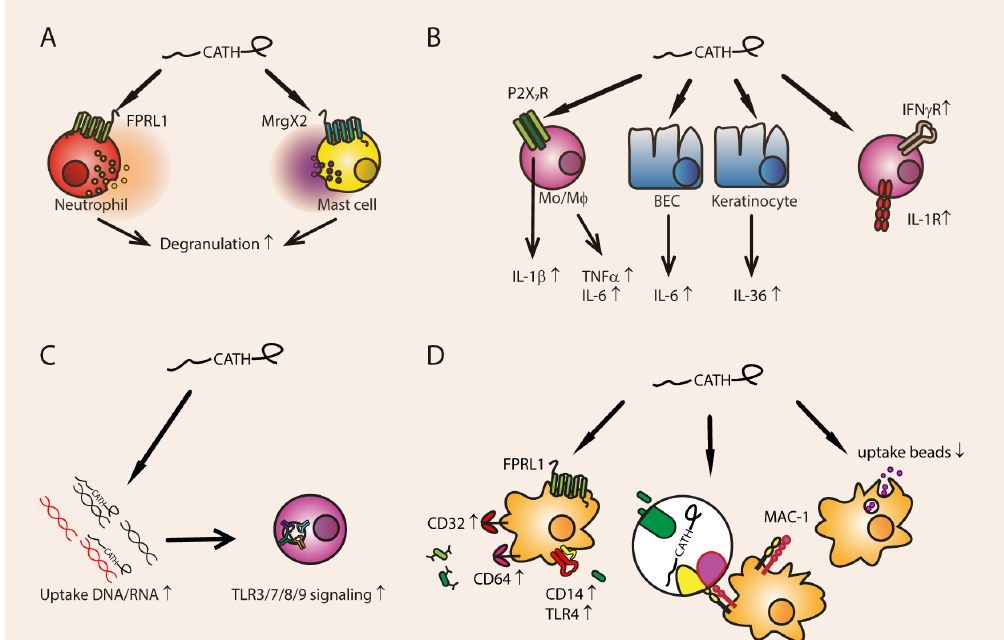
Figure 2. Pro-inflammatory functions of cathelicidins. ( A ): Neutrophil degranulation is stimulated through FPRL1, while mast cell degranulation is induced through MrgX2. ( B ) Cathelicidins induce production of IL-1 β , TNF α , and IL-6 by monocytes/macrophages through the P2X 7 receptor. Broncho-epithelial cells are induced to produce IL-6, and keratinocytes produce IL-36. Cathelicidins induce upregulation of IL-1R and IFN γ R. ( C ) Cathelicidins bind to extracellular DNA and RNA and increase extracellular nucleotide uptake. After the cathelicidins are degraded in the endosomal compartment, TLR3, 7, 8, and 9 signaling is increased. ( D ) Through FPRL1 signaling, Fc γ Rs CD32 and CD64 on macrophages are increased, which enhances phagocytosis of opsonized bacteria. Additionally, TLR4 and CD14 are upregulated, which increases phagocytosis of Gram-negative bacteria. Cathelicidins can also bind to pathogens and thereby opsonize directly through increased uptake by MAC-1 (CR3). In contrast, the uptake of latex beads is decreased by many